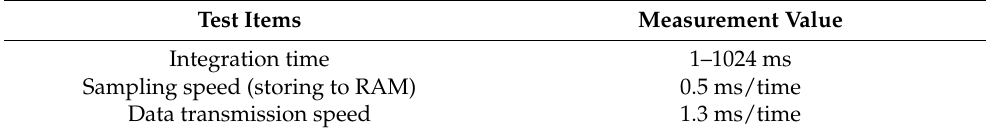
Table 2. Result of debugging and testing